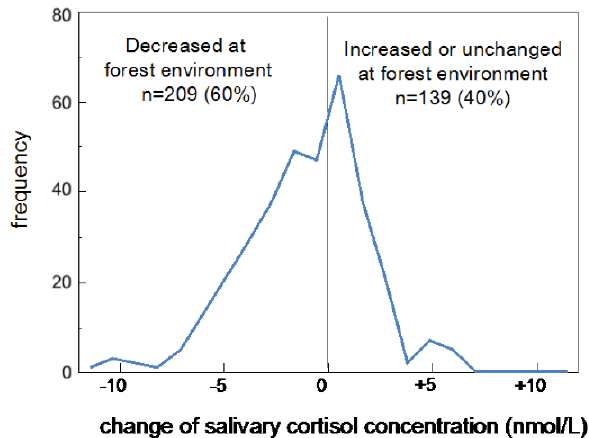
Figure 2. Histogram showing the differences in cortisol concentrations between urban and forest environments. Approximately 60% ( n = 209) of the participants exhibited decreased cortisol concentrations in a forest environment, and the remaining 40% ( n = 139) exhibited increased ( n = 118) or unchanged ( n = 21) cortisol concentrations.